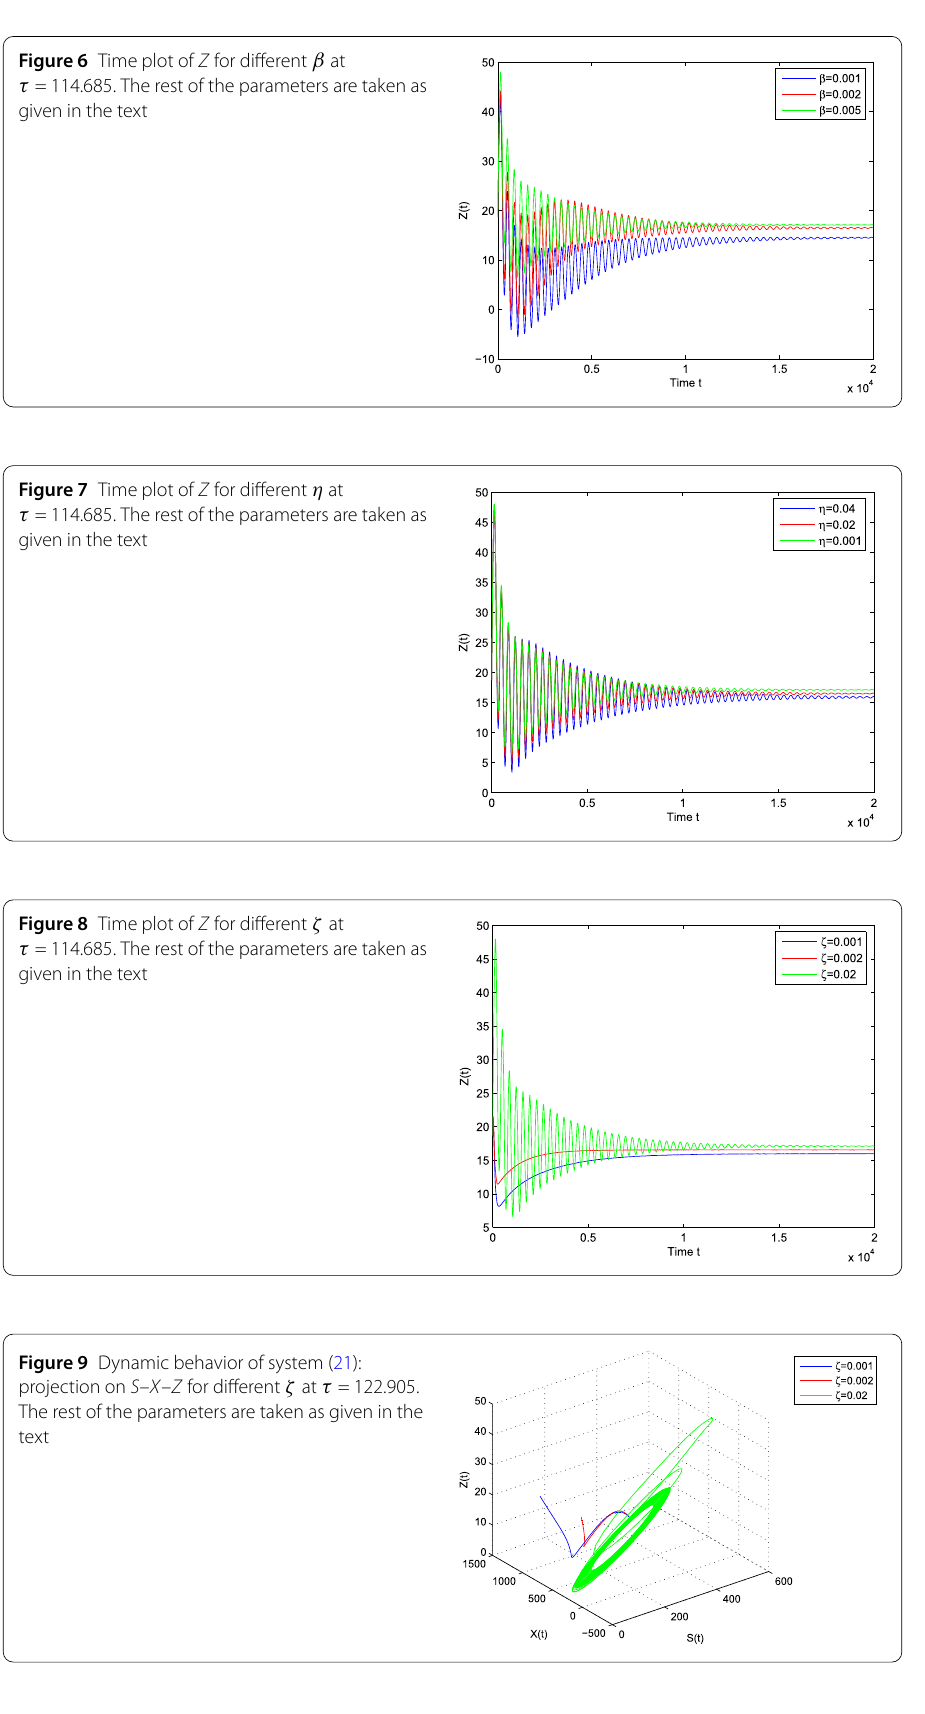
Figure 6 Time plot of Z for different β at τ = 114.685. The rest of the parameters are taken as given in the text